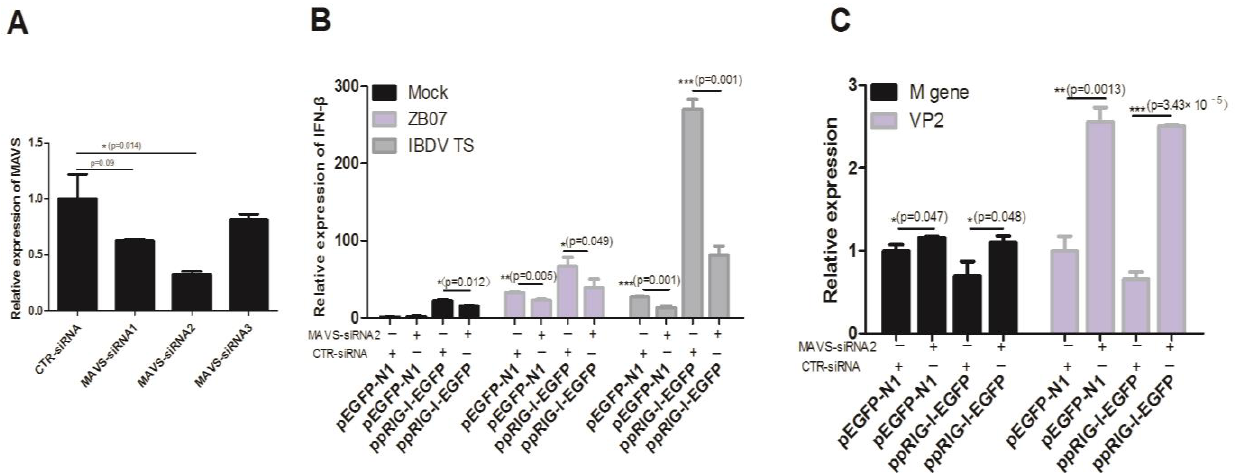
Figure 9. Effect of pRIG-I transfection on antiviral response in MAVS-knockdown DF-1